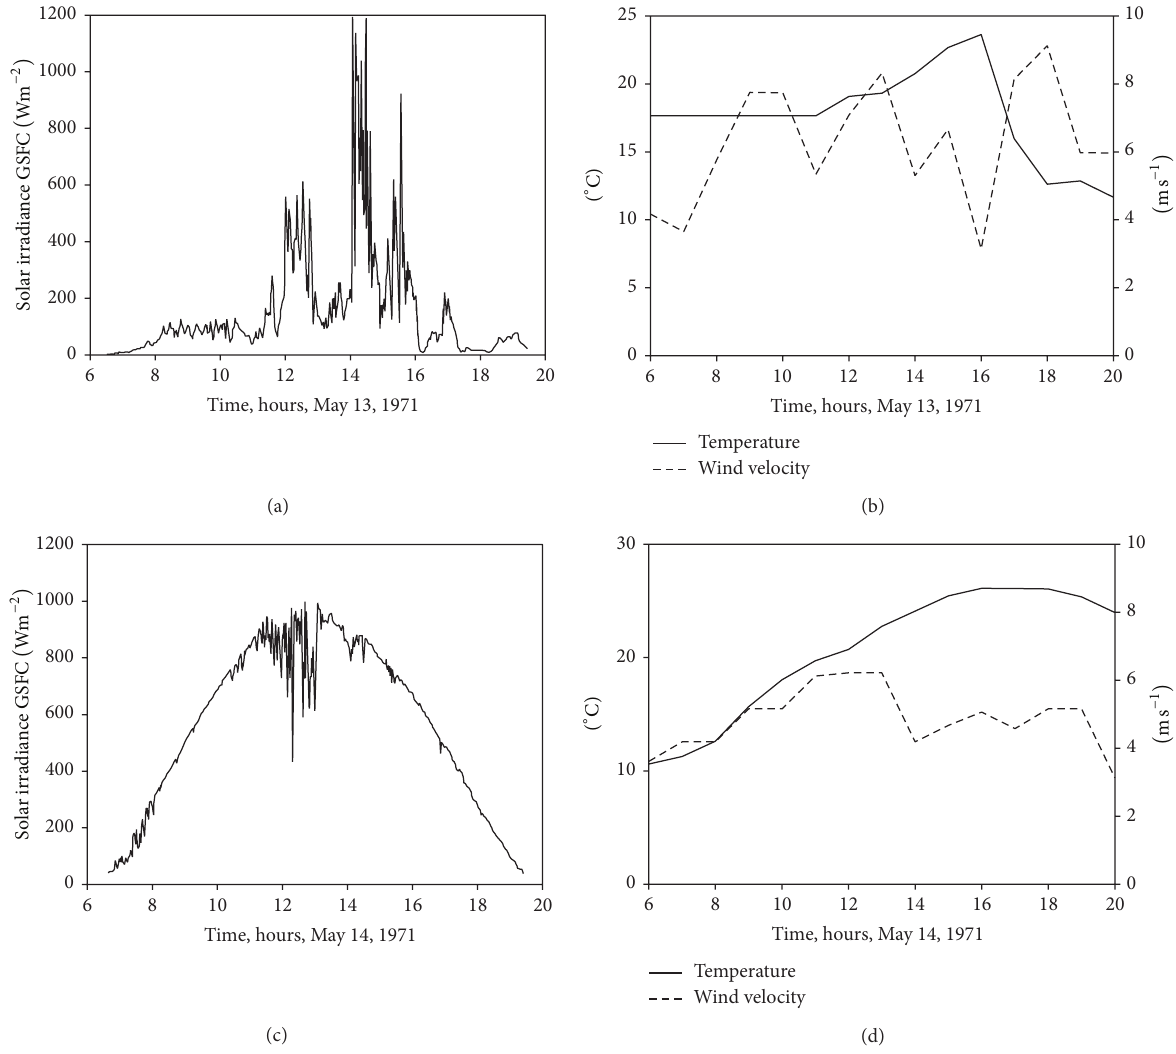
Figure 5: Ambient conditions on May 13, 1971 (a), (b), and May 14, 1971 (c), (d). Solar irradiance is represented in left side, and temperature and wind velocity are in right